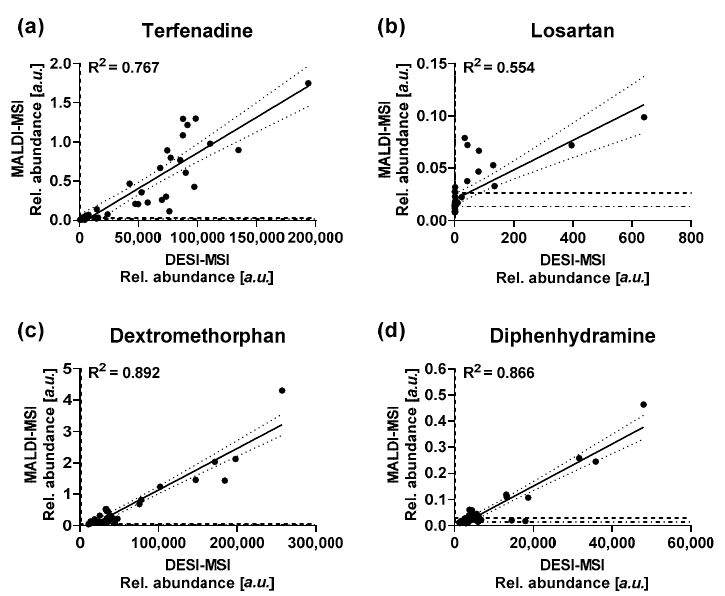
Figure 7. Correlation of the average drug abundances as detected by DESI-MSI and MALDI-MSI for ( a ) terfenadine, ( b ) Losartan, ( c ) dextromethorphan and ( d ) diphenhydramine. — Indicate best-fit linear regression lines . . . indicate the 95% confidence interval of the regression lines - · - indicate the LOD for the respective MSI technique --- indicate the LLOQ for the respective imaging technique.